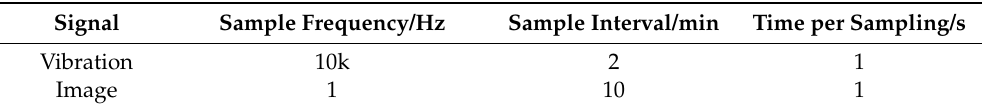
Table 7. Signal acquisition parameter settings.